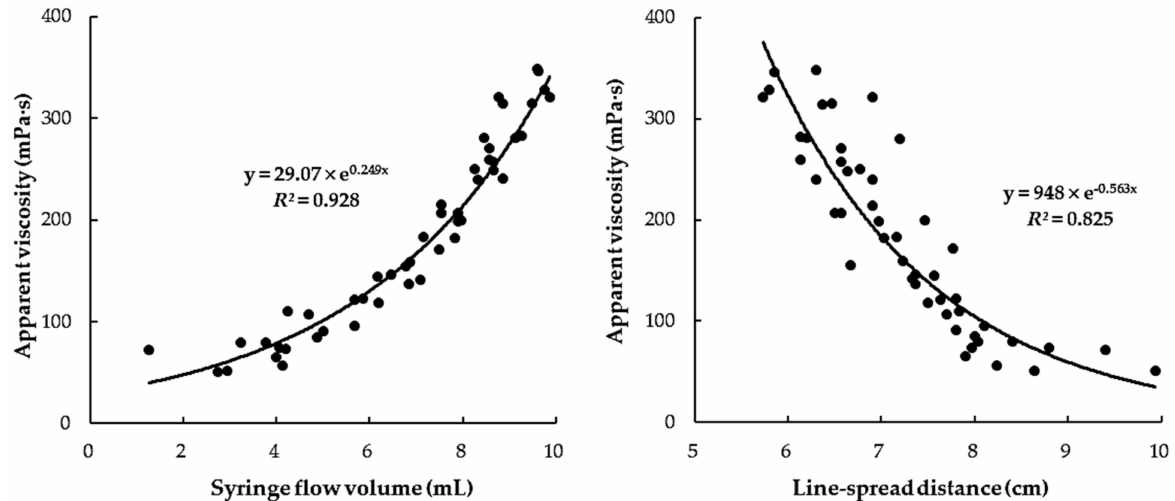
Figure 2. Correlation between apparent viscosity ( η a, 50 ) and flow volume (mL) by SFT or flow distance (cm) by LST of all thickened beverages within the nectar-thick viscosity range (51–350 mPa ·